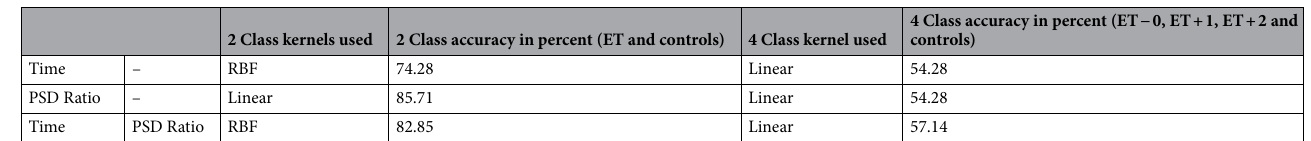
Table 4. SVM classification